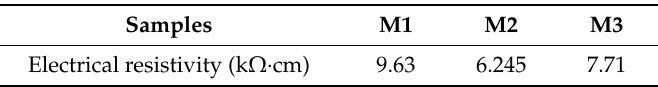
Figure 7. The real part of complex permittivity ( a ), the imaginary part of complex permittivity ( b ), dielectric loss tangent ( c ), the real part of complex permeability ( d ), the imaginary part of complex permeability ( e ), magnetic loss tangent ( f ). Table 4. Resistivity values of M1, M2, and M3.